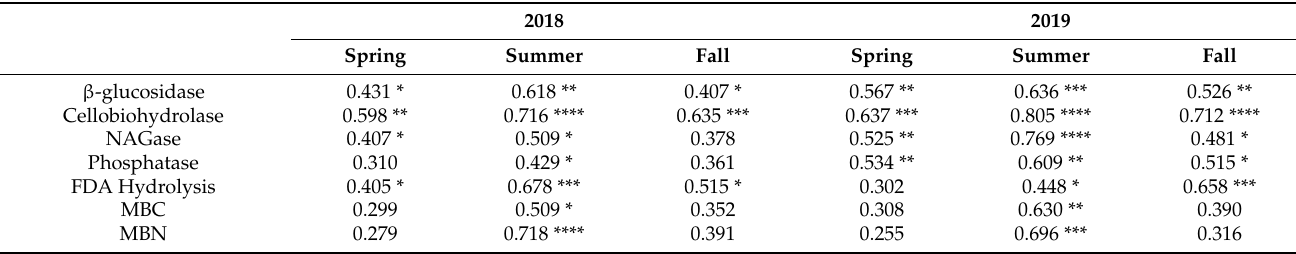
Table 3. Correlations of with annual winter plant biomass input with enzyme activities and microbial biomass from each timepoint # .